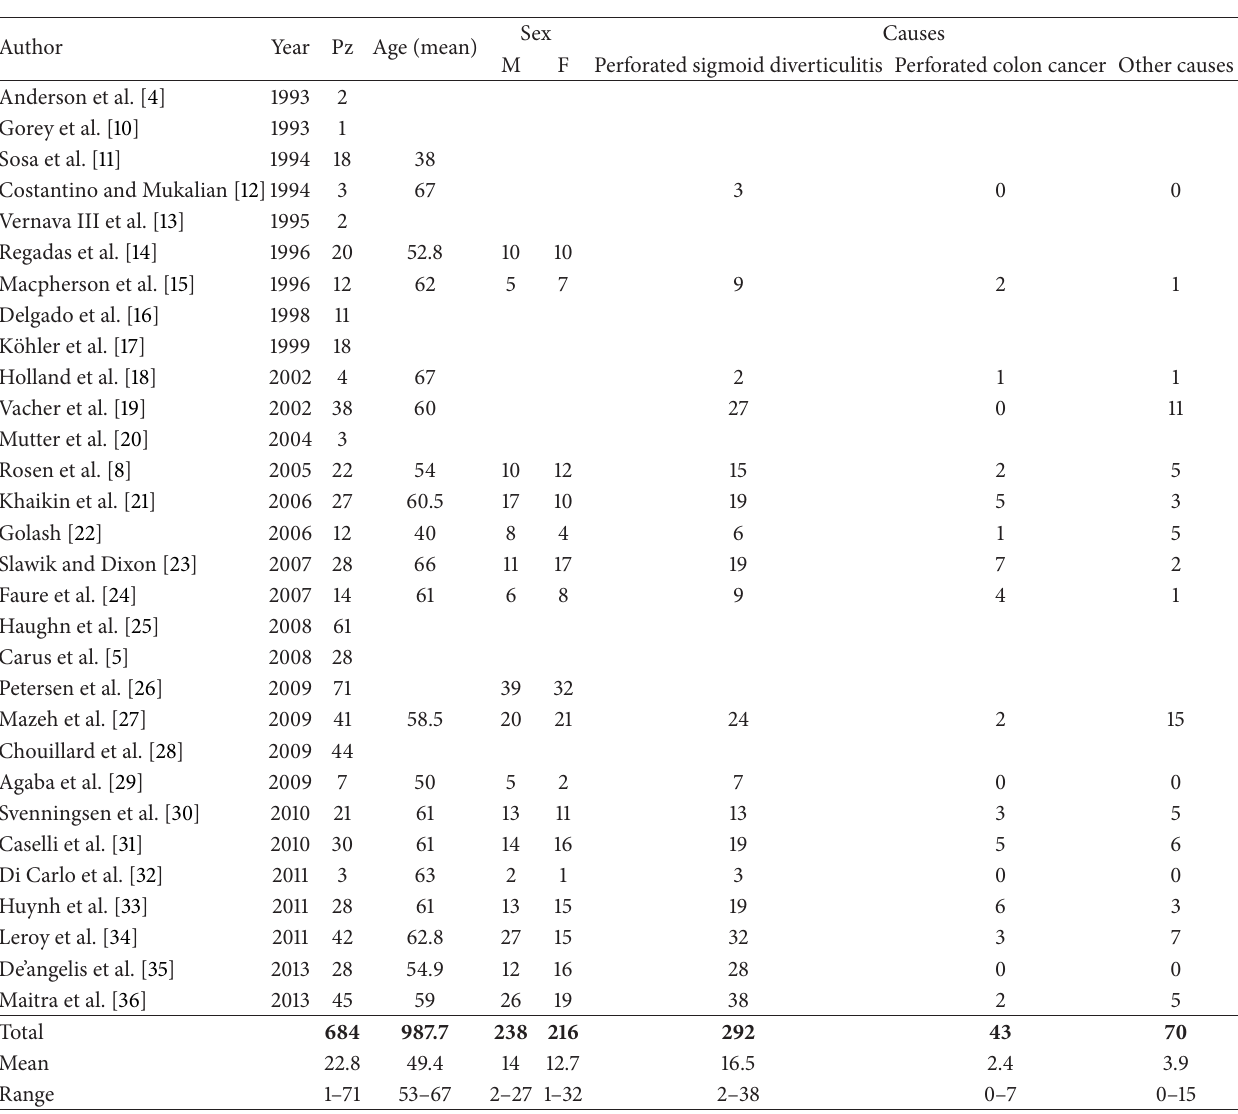
Table 1: Preoperative